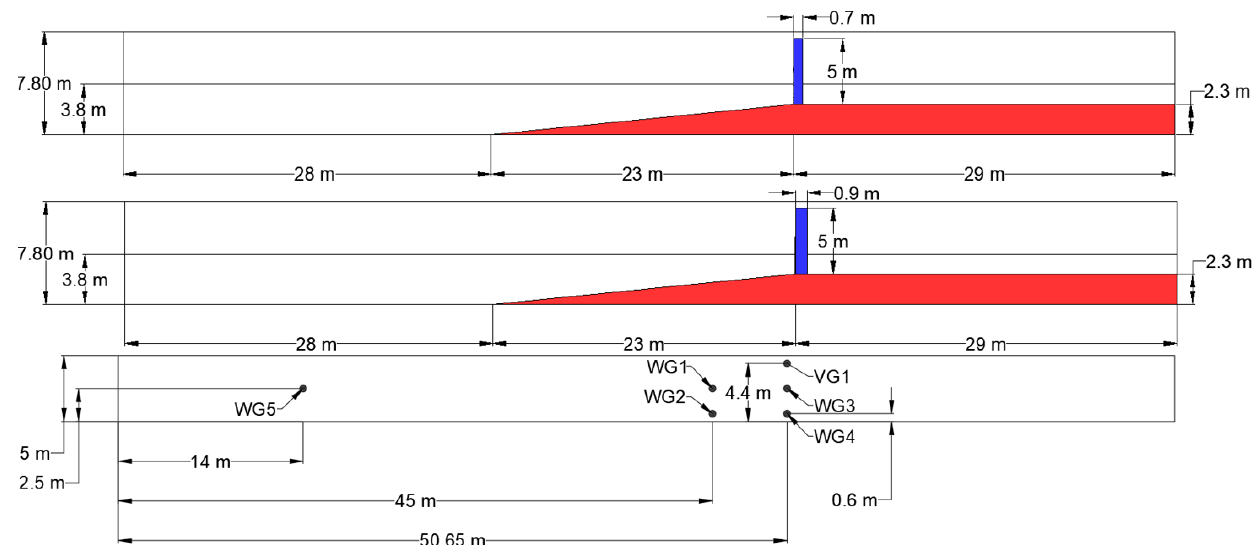
Figure 1. Schematic representation of the Numerical Wave Tank (NWT) with the two vertical cylindrical substructures: front view ( top ); top view ( bottom ).